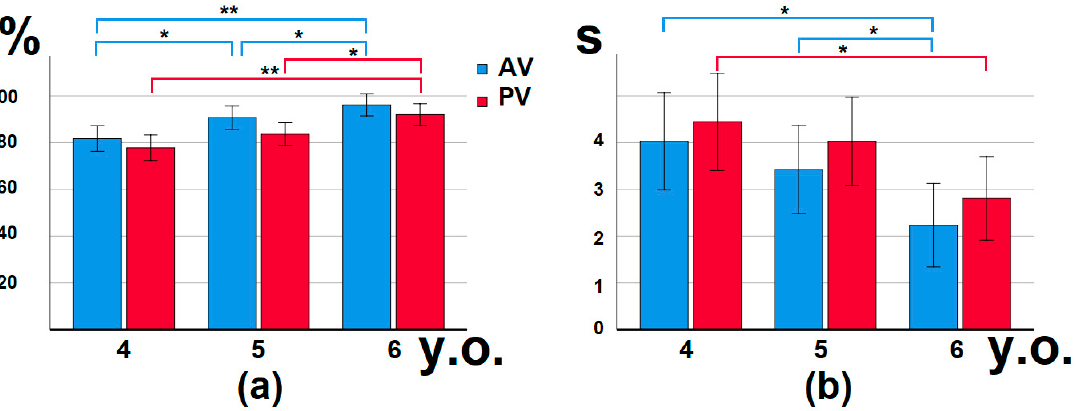
Figure 2. Correct identification (%) of a picture in the sentence-picture matching task ( a ) and RT (s) ( b ) to sentences with active (AV) and passive (PV) voice of four-to-six-year-old children, which had correct answers that exceeded 60% in PV sentences ( n = 50), * p < 0.05, ** p < 0.001, 95% confidence interval.